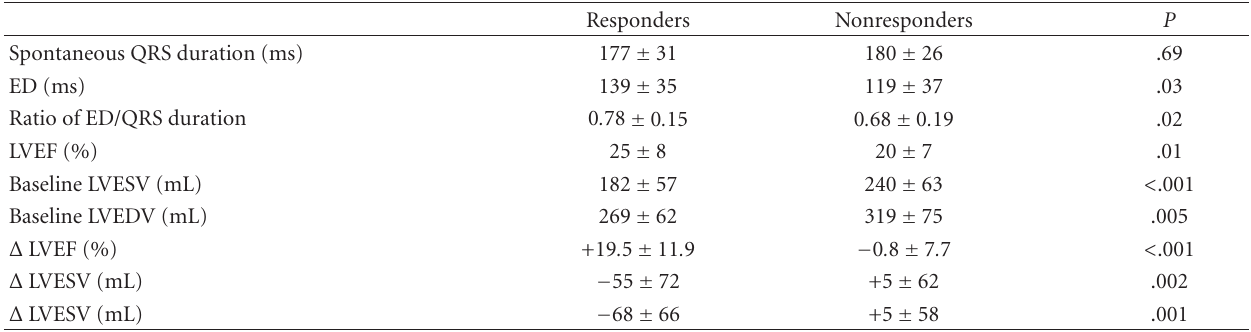
Table 2: Comparison of echocardiography and electrical parameters in responders and nonresponders.